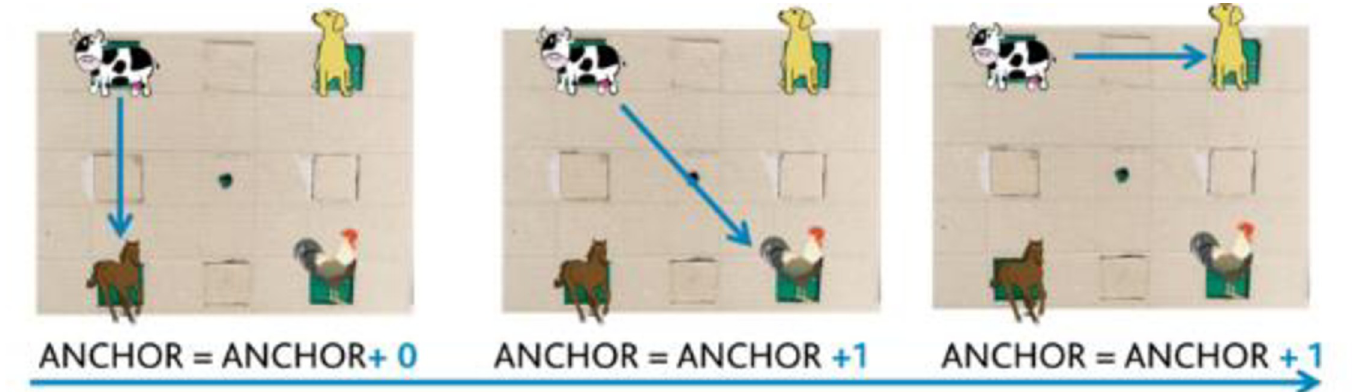
Fig 7. Example of Audio anchor calculation. The index equals 0 at the beginning of the test. The index increased correlated with more attempts started with the same speaker. In the represented example, the final value would have been: 0+1+1 = 2. Depicted animals were downloaded from a royalty-free images web archive (https://